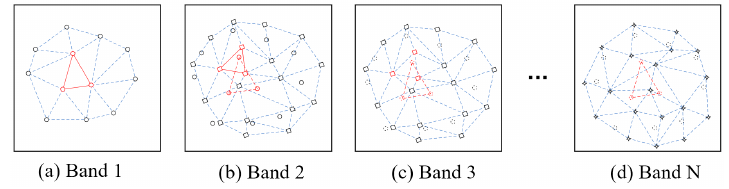
Figure 7. Full-spectrum registration diagram.